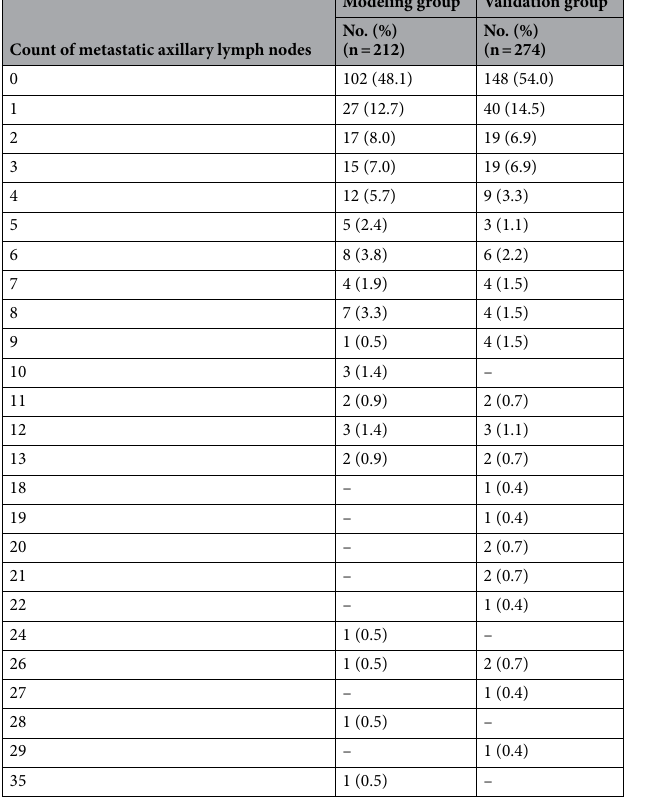
Table 2. Distribution of metastatic axillary lymph nodes.